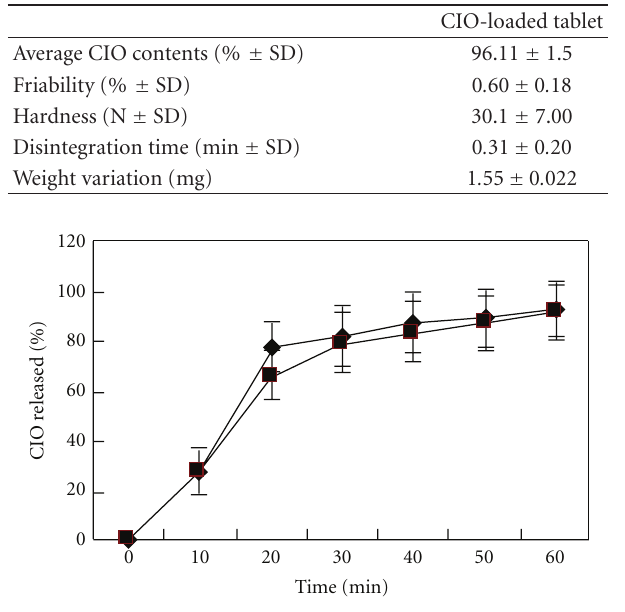
Figure 3: Mean whole blood concentrations of CIO in rats following oral doses of 100 mg in the form of CIO-SEDDS and CIO- LLT. The total plasma concentrations of drug after oral administration of CIO could not be